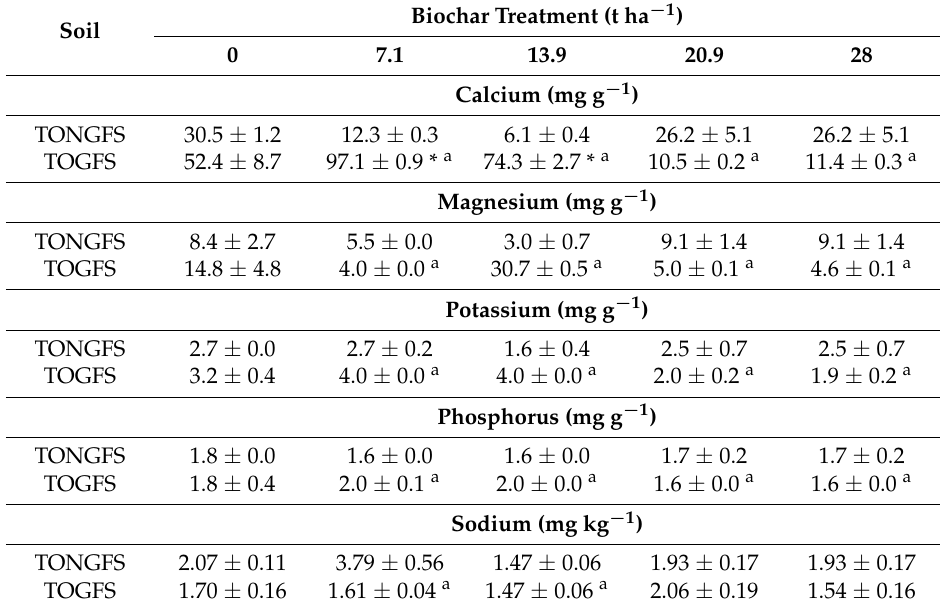
Table 5. Effect of different application rates of palm bunch biochar applied to sandy loam soil on the mineral composition of T. occidentalis leaves cultivated on gas flared and non-gas flared